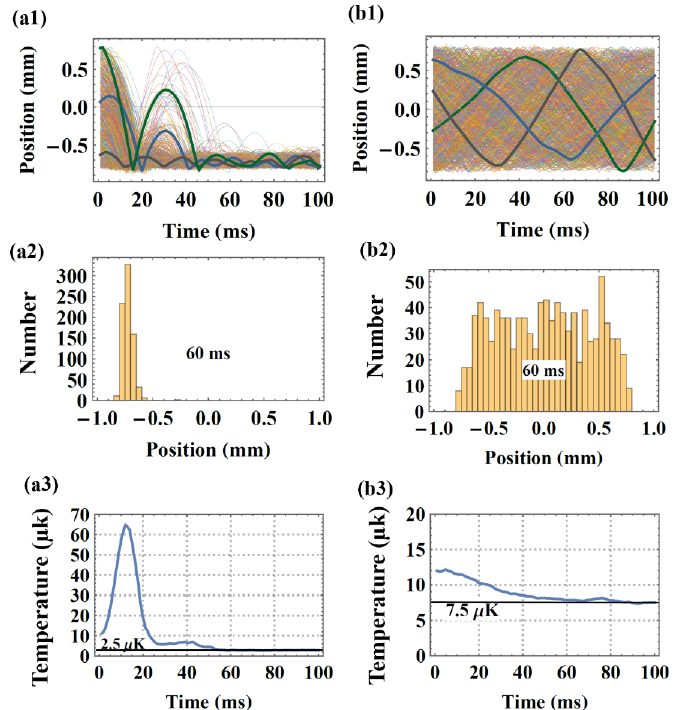
Figure 3. Monte Carlo simulation of ensemble atoms in the single-frequency, red MOT associated with spontaneous emission. ( a1 – a3 ) show the results of MOT on ground, and ( b1 – b3 ) show the results of MOT in a µ -gE. In ( a1 ) and ( b1 ), three cures are randomly selected and thickened to be